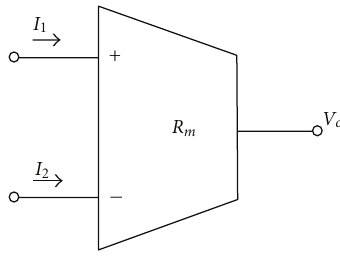
Figure 1: OTRA circuit